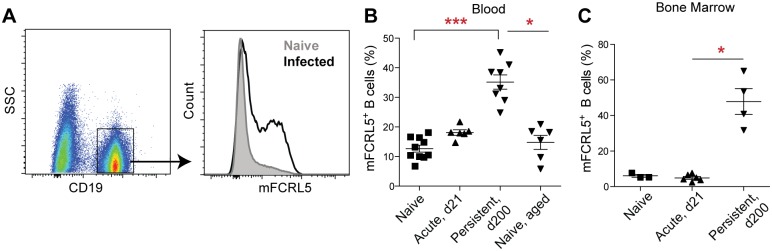
Increased FCRL5+ B cell populations in infected mice.(A) Gating strategy and histogram plot showing FCRL5 expression on CD19+ B cells from representative naive and persistently infected mice. (B, C) The frequency of FCRL5+ B cells was quantified as a percentage of total B cells in the blood (B) or bone marrow (C) of mice that were uninfected (naive), infected for 21 days (acute), or persistently infected for 200 days (persistent). Eight-month-old naive mice (naive, aged) were also assessed as age-matched controls for persistently infected mice. Each symbol represents an individual mouse; results are representative of four (B) or two (C) independent experiments. *, p < 0.05; ***, p < 0.001 by Kruskal-Wallis test with Dunn's post-test.